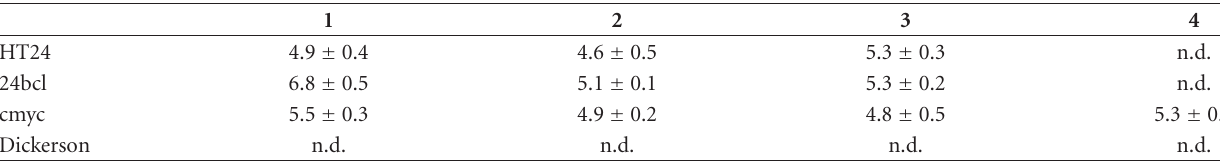
Table 2: Logarithm of the binding constants (log K ) calculated from data recorded throughout fluorescence titrations using Equispec program assuming a 1:1 stoichiometry DNA:ligand for the interaction complex (details in materials and methods). Compounds 1–4 correspond to the acridine dimers and trimers prepared in this study. HT24, 24bcl, cmyc, and Dickerson correspond to oligonucleotide sequences shown in Table